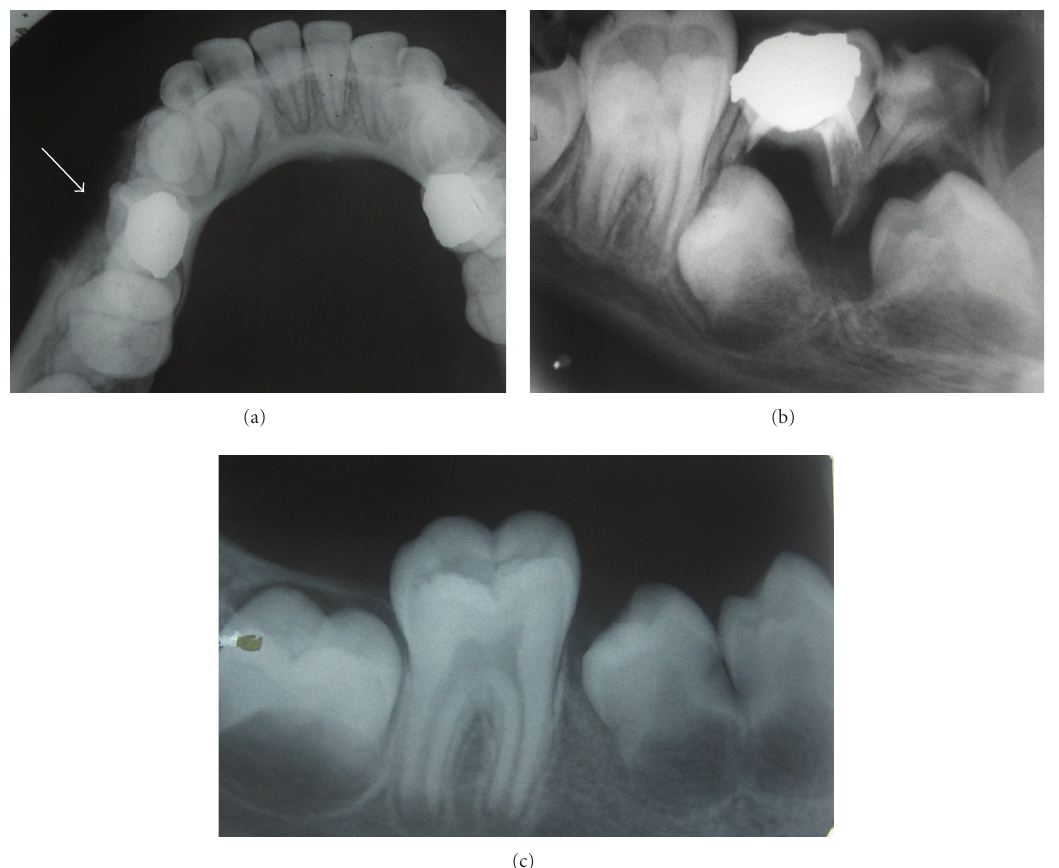
Figure 2: (a) Mandibular occlusal radiograph in case 2 showing erosion of the buccal cortex of the mandible. (b) Intraoral periapical radiograph showing radiolucency in relation to 84, 85 along with displacement of the underlying successor teeth. (c) Intraoral periapical radiograph showing eruption of 44, 45 following extraction of 84, 85 and periapical curettage.